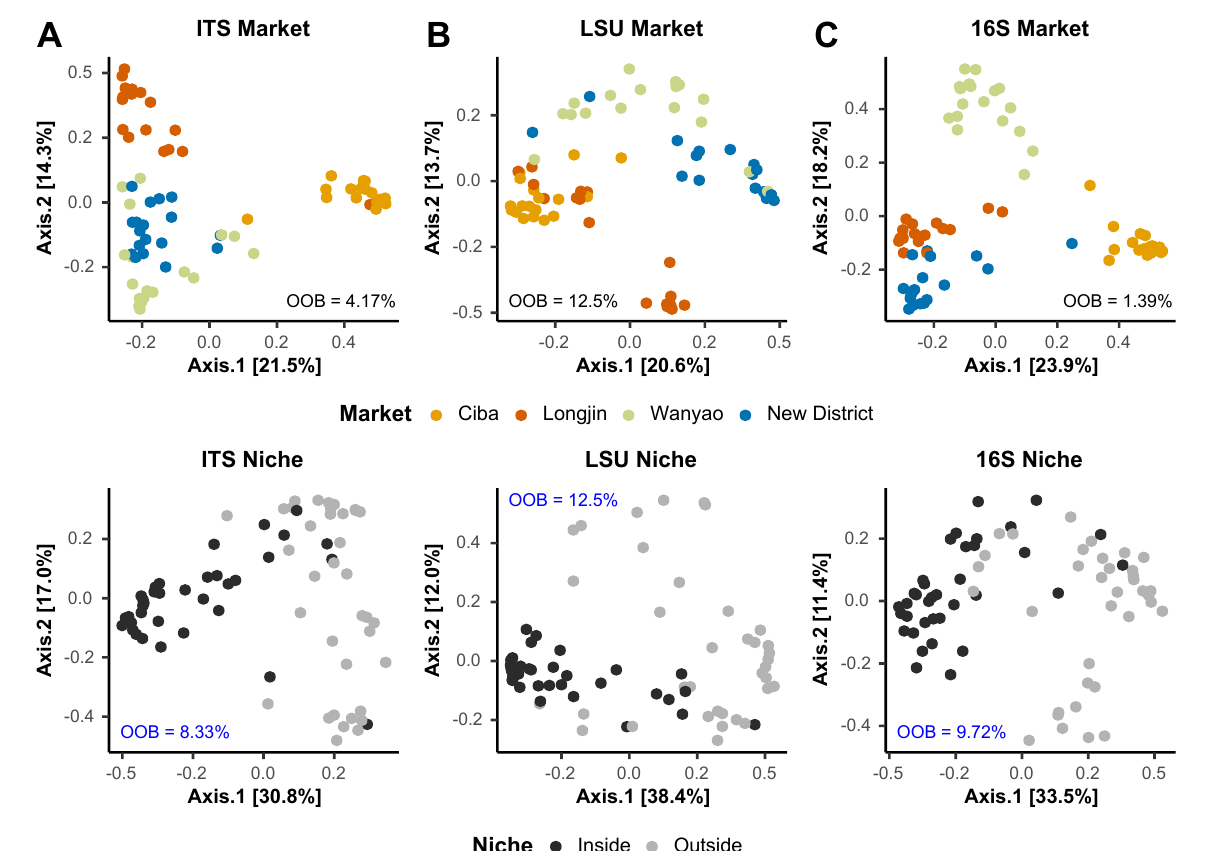
Figure 4. Metric multidimensional scaling (MDS) ordinations of random forest models 1-proximity matrix to visualize accuracy of market and niche sample classification in the ( A ) ITS dataset, ( B ) LSU dataset, and ( C ) 16S dataset. Samples that cluster within the wrong groups may represent misclassifi-